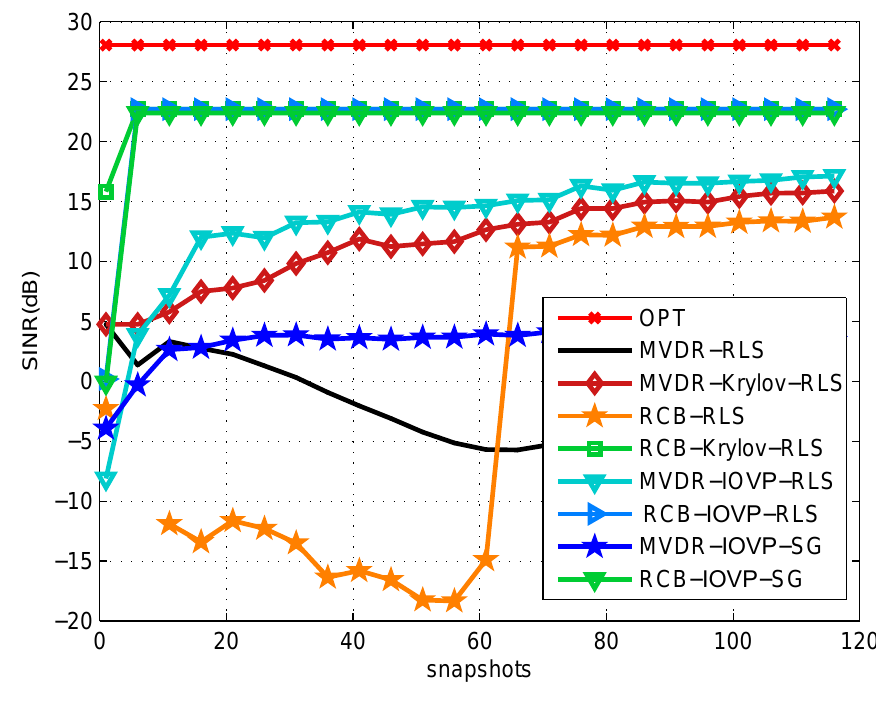
Figure 3. SINR performance against the number of snapshots without steering vector mismatch.